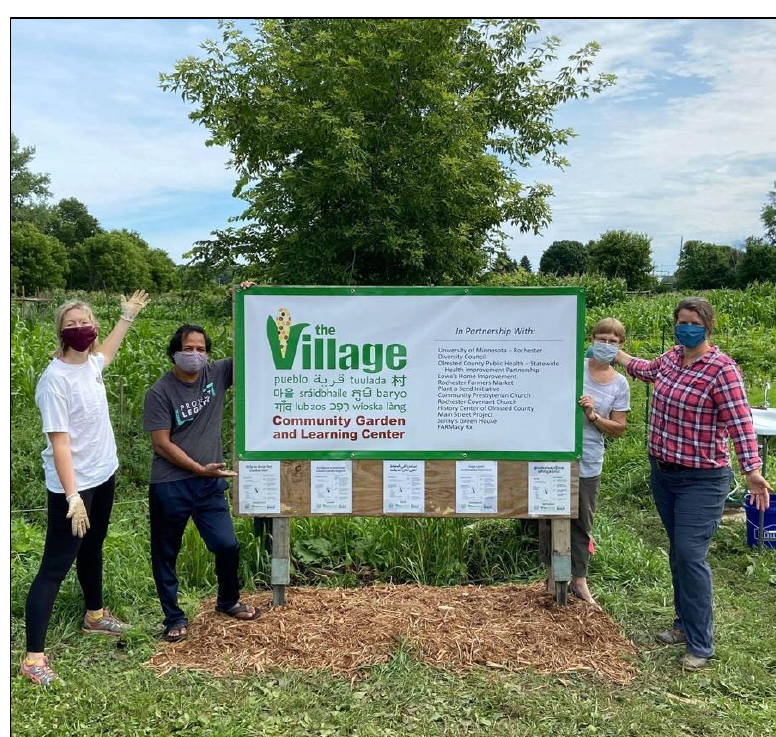
Left to right: Anna Oldenburg, Kim Sin, Elena Arsentyeva, and Amanda Nigon-